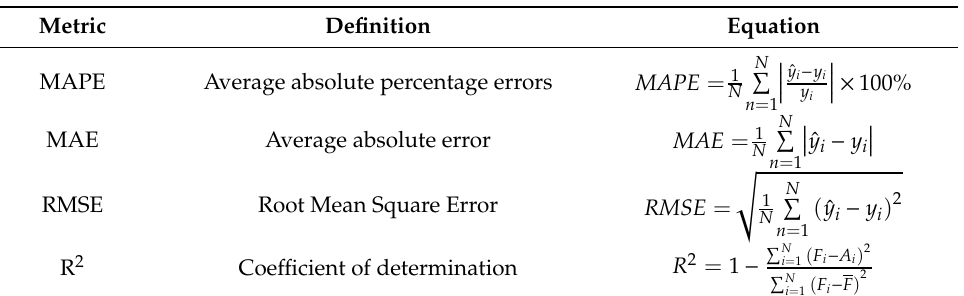
Table 2. The evaluation metrics.